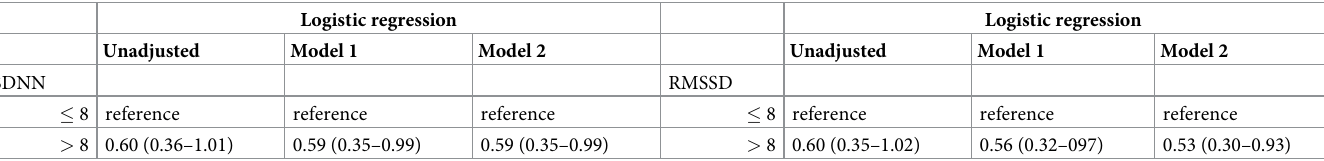
Table 5. Odds ratio for indication for ICU admission within seven days after hospital